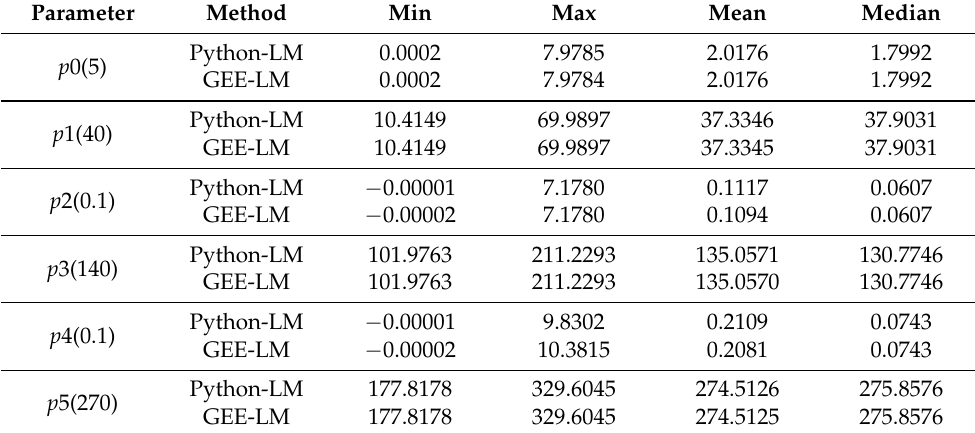
Table 2. Statistics of the parameters of the double-logistic equations fitted with MODIS annual LAI data by the Python and GEE platform in the test